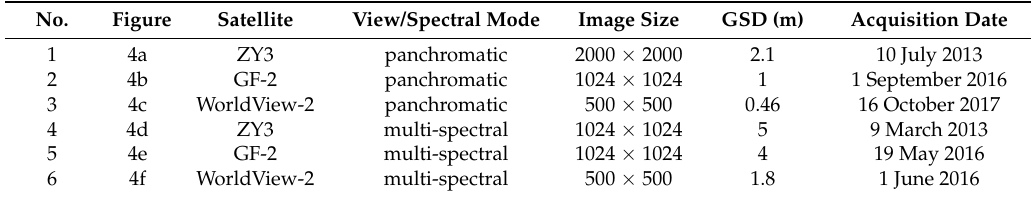
Table 5. Parameters of experimental